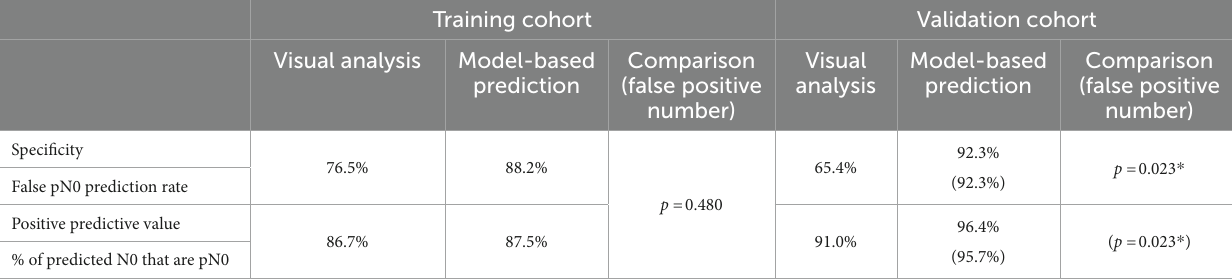
TABLE 3 Specificity and positive predictive value of visual analysis and model-based